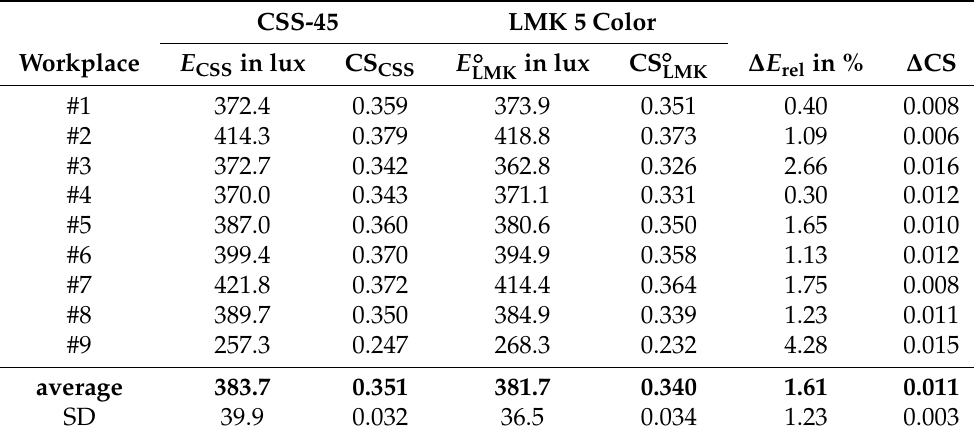
Table 1. Illuminance and CS half-space estimates calculated from the CSS-45 spectroradiometric mea- surements and the spatially resolved output of the LMK-5 color imaging photometer. Additionally tabulated are the corresponding error estimates ∆ E rel and ∆